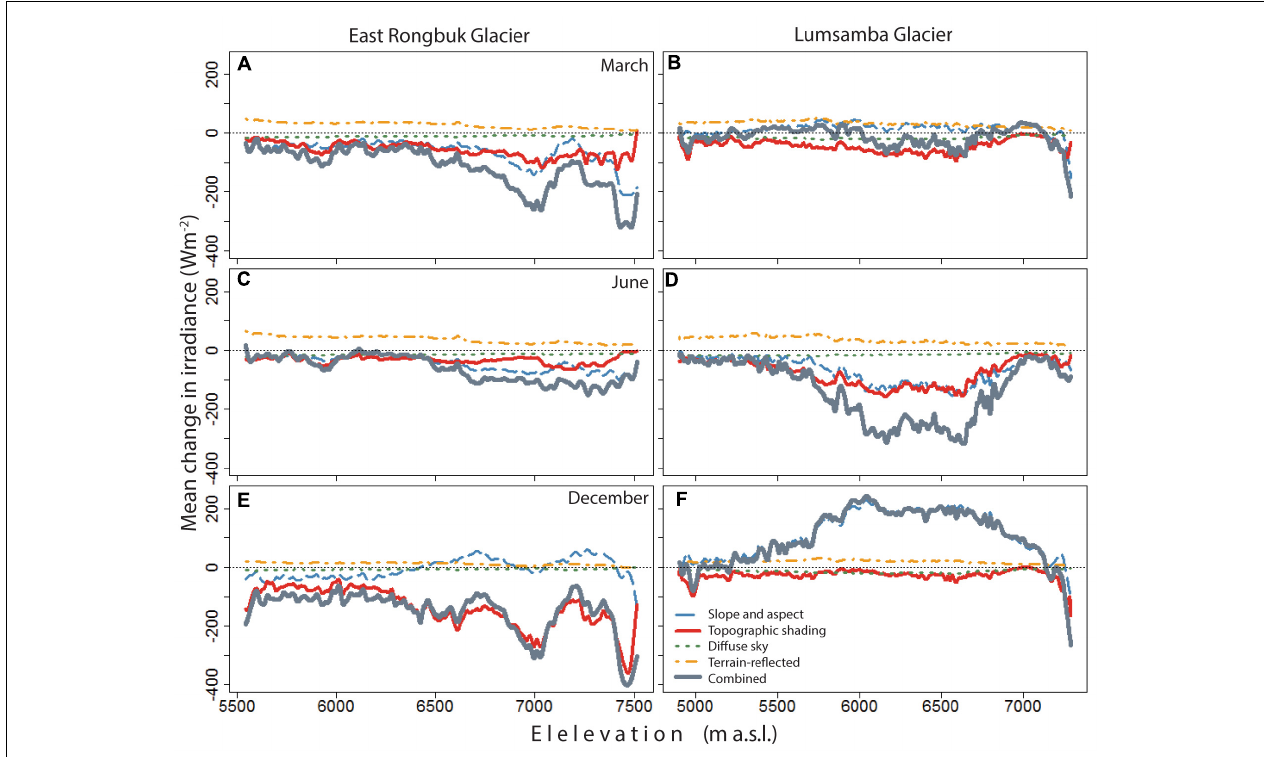
FIGURE 3 | Daily mean change in irradiance vs. elevation due to different terrain attributes (and their combined effect) for East Rongbuk Glacier (left panels) and Lumsamba Glacier (right panels). The model is run on the spring equinox—March 21 (A,B) , summer solstice—June 21 (C,D) , and winter solstice—December 21 (E,F)